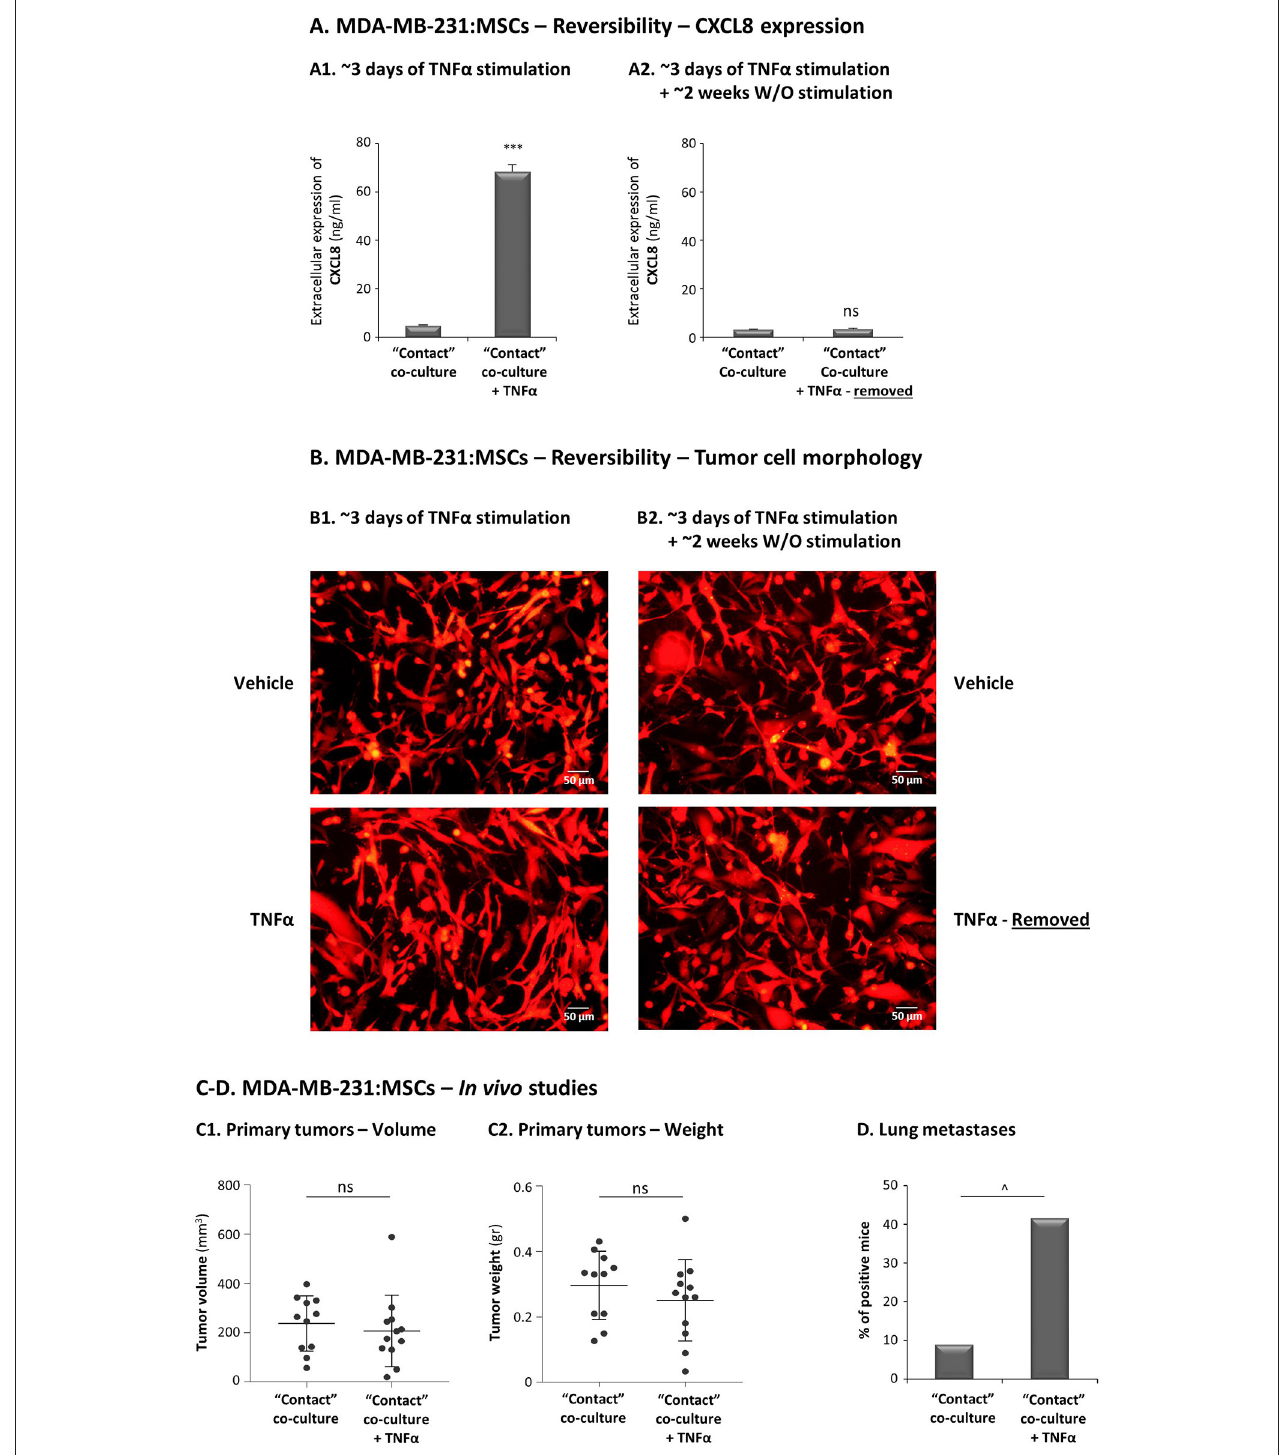
FIGURE 13 | TNF α promotes the metastatic potential of TNBC cells grown in contact with MSCs. (A,B) Reversibility of TNF α -induced tumor-promoting phenotypes, generated in vitro in “Contact” MDA-MB-231:MSC co-cultures following TNF α removal. mCherry-MDA-MB-231 cells were co-cultured in “Contact” conditions with MSCs in the presence of TNF α (10ng/ml) or vehicle control for 67h (termed “ ∼ 3 days of TNF α stimulation") (A1,B1) . Then, vehicle-treated and TNF α -stimulated MDA-MB-231:MSCs co-cultures were re-cultured without further TNF α stimulation for additional 10–14 days (termed “ ∼ 3 days of stimulation + ∼ 2 weeks W/O TNF α stimulation) (A2,B2) . At both time points ( ∼ 3 days and ∼ 2 weeks), extracellular CXCL8 levels were determined in cell supernatants by ELISA (A) and tumor cell